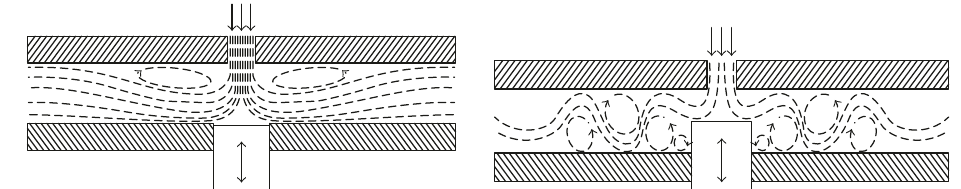
Figure 7: Characteristics of fl ow for a jet impinging on a fl at surface and an actuating slab [35].